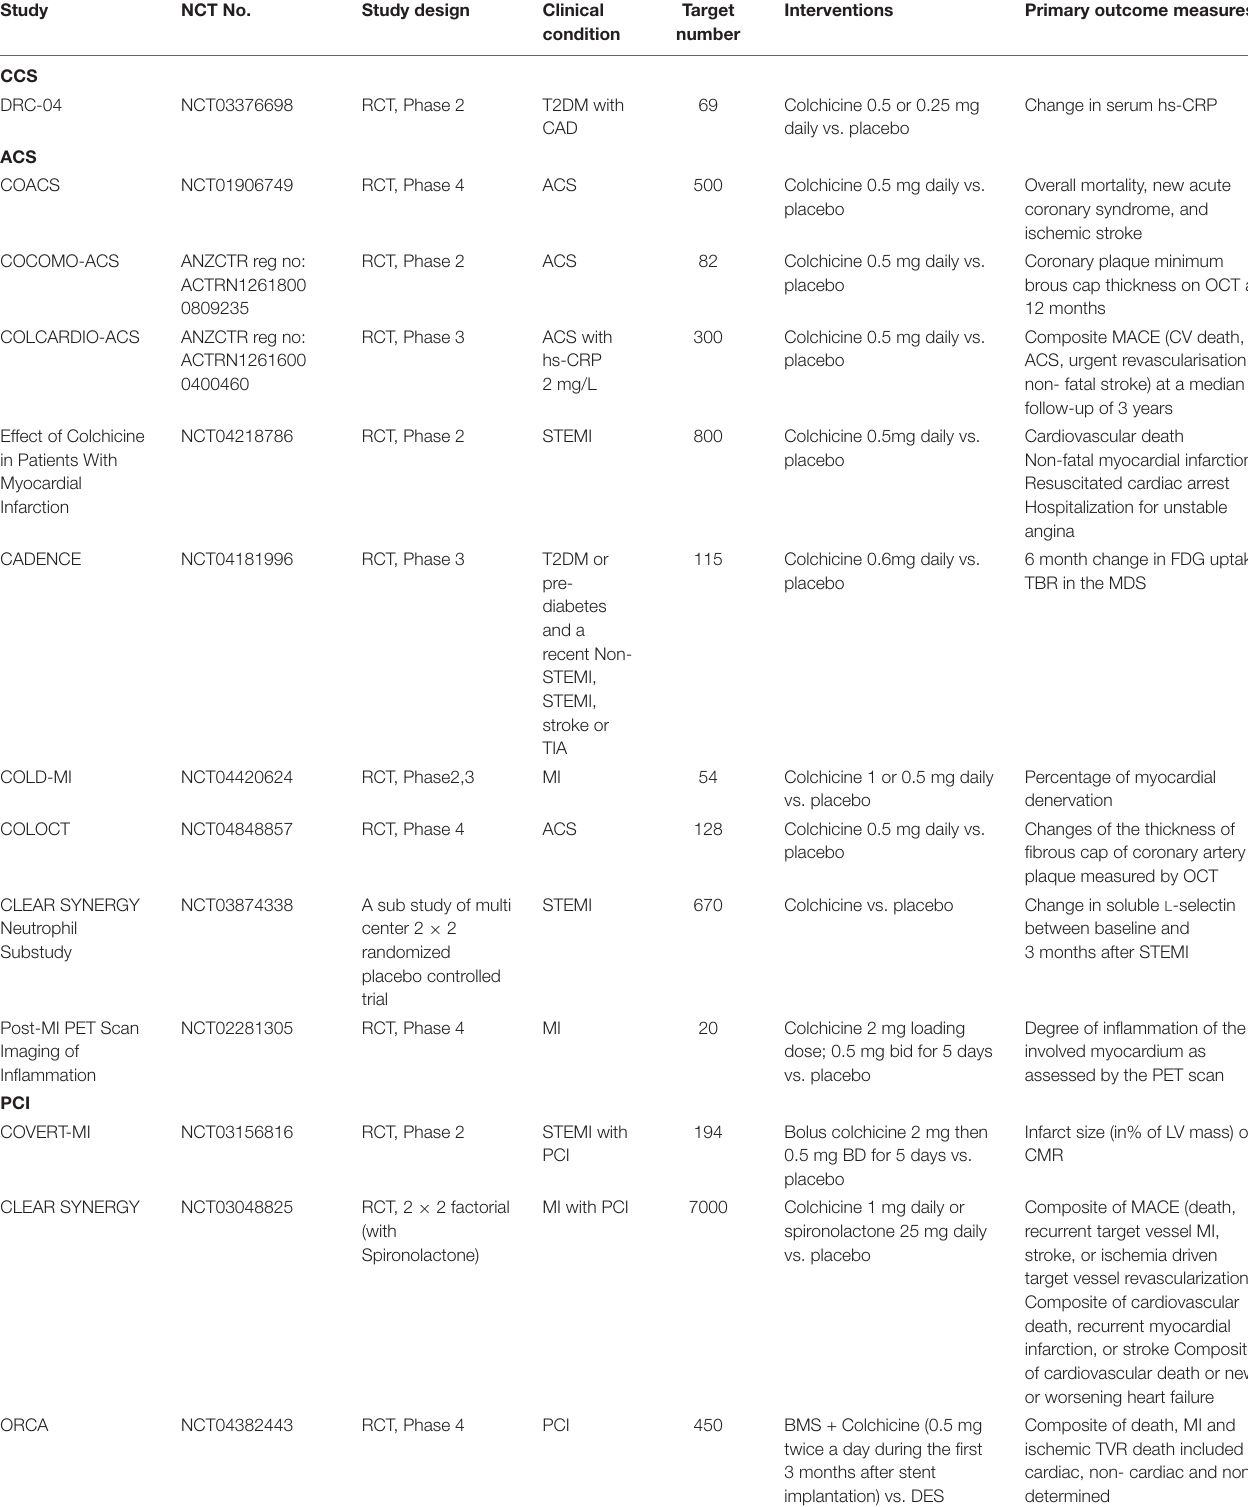
TABLE 2 | Ongoing clinical studies of colchicine in coronary artery